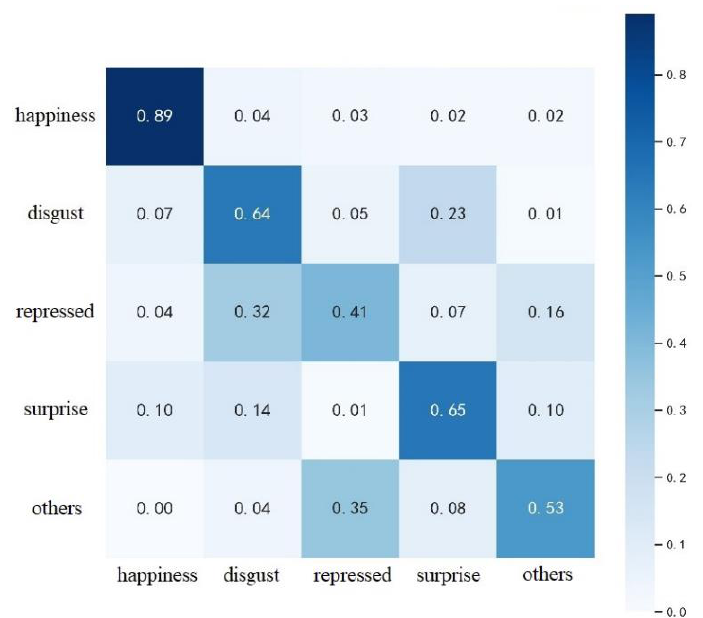
Figure 8. Confusion matrix for the CASME II dataset.